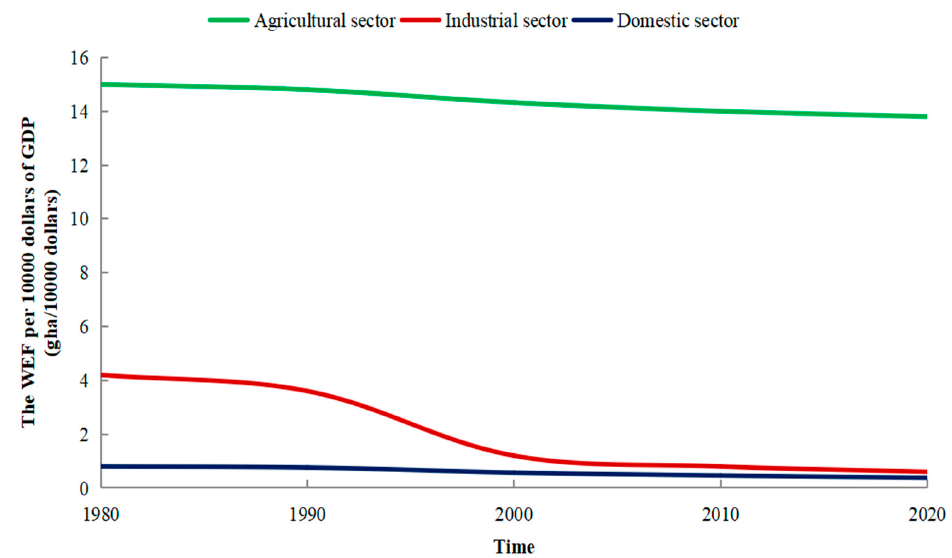
Figure 8. Changes in the WEF efficiency in Japan from 1980 to 2020.